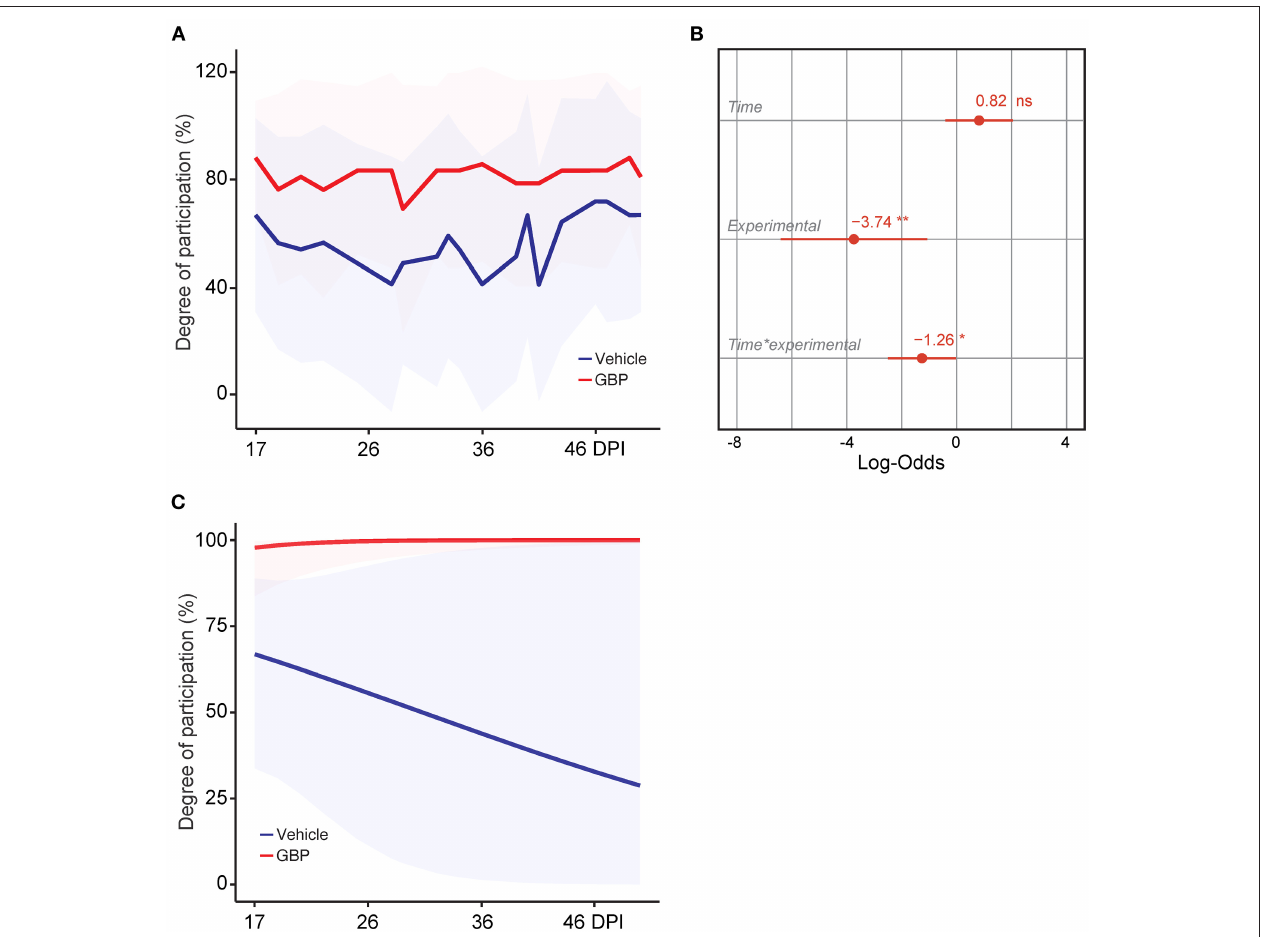
FIGURE 4 | Control mice lack motivation after chronic SCI. (A) Intrinsic motivation was measured by assessing the degree of participation in rehabilitative treadmill training. Mean and standard deviation (vehicle with treadmill training n = 13 and GBP with treadmill training n = 14). (B) Analysis of (A) . Variable effects on motivation toward rehabilitative treadmill training in SCI mice administered vehicle and GBP are displayed as coefficients with confidence intervals (Generalized linear mixed effect model for repeated measures * p < 0.05, ** p < 0.01, ns not significant, vehicle with treadmill training n = 13 and GBP with treadmill training n = 14 mice). (C) Predicted changes in motivation toward the rehabilitative treadmill training in SCI mice administered vehicle or GBP. Shaded error bands indicate confidence intervals.